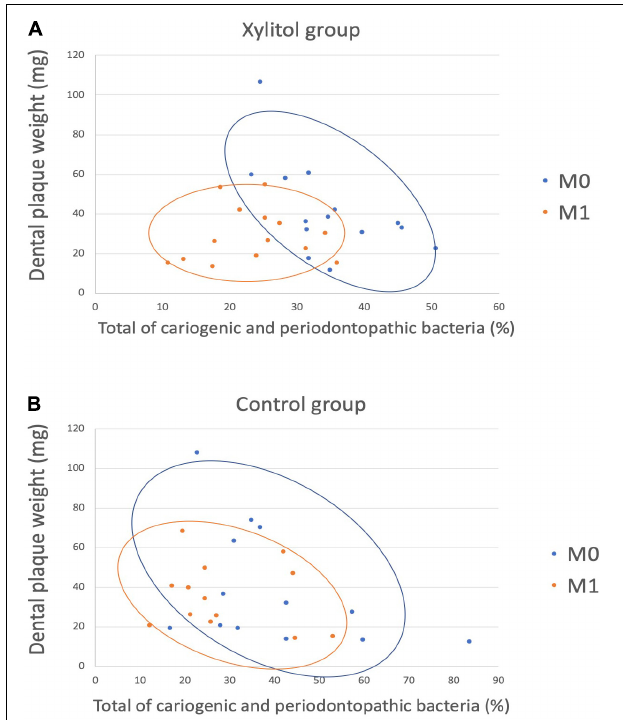
FIGURE 8 | A scatter plot showing the distribution between dental plaque accumulation and a total of cariogenic and periodontopathic bacteria among the (A) Xylitol and (B) Control group, showing the confidence ellipses (51). Total of cariogenic and periodontopathic bacteria and dental plaque accumulation are plotted on the horizontal and vertical axes, respectively. Each blue dots represent baseline (M0), and the orange dots represent